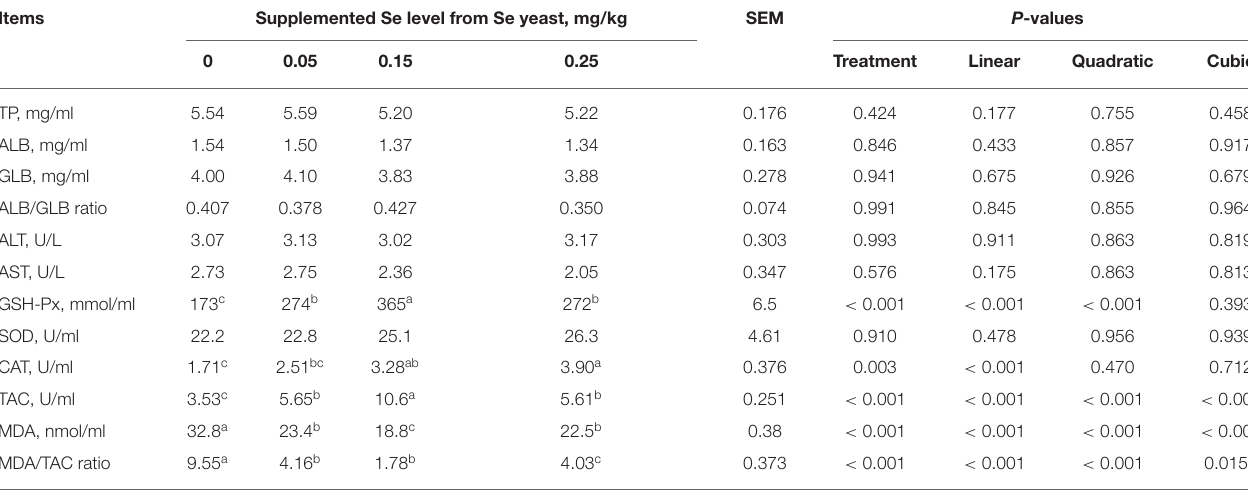
TABLE 4 | Effect of dietary Se yeast supplementation on the biochemical and the antioxidant indices in plasma of Longyan laying ducks ( n = 6) a . Items Supplemented Se level from Se yeast, mg/kg SEM P -values